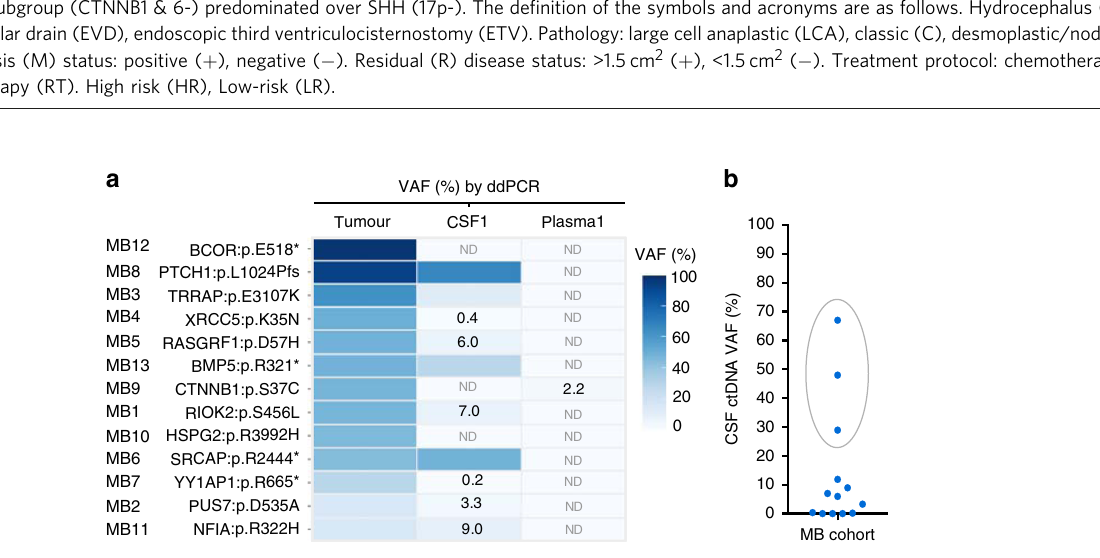
Fig. 1 Project outline and characterisation of a cohort of 13 paediatric patients with MB. a Study schema indicating the patient samples obtained and the methodology used for the analysis. b Molecular features, including driver events in MB, identi fi ed from the WES characterisation of 13 MB patients. The number of mutations identi fi ed for each patient is indicated in the top and the proportion of patients with each alteration on the right. Distinct alterations are indicated in the colour legend. c Summary of the MB common molecular alterations investigated for the classi fi cation into subgroup and association of risk strati fi cation. d Clinicopathological characteristics, molecular features, MB-subgroup classi fi cation and risk strati fi cation (based on Schwalbe et al., 2017 5-year progression-free survival (PFS)) for the 13 MB patients. PFS indicated as years until the date of progression (and if not applicable, death) in red or last medical check-up in black. The frequency of somatic mutations in coding regions per Mb (Mut/Mb) was calculated based on a 50.4 Mb (MB1- MB12) and 17.7 Mb (MB13) WES panel. CNV deletion (log 2 value < − 1, blue), ampli fi cation (log 2 value >1, red). For the cytogenetic analysis, the threshold for the percentage of arm-level or whole chromosome gain/loss was determined by the mean and the percentiles of the events from the cohort, greater